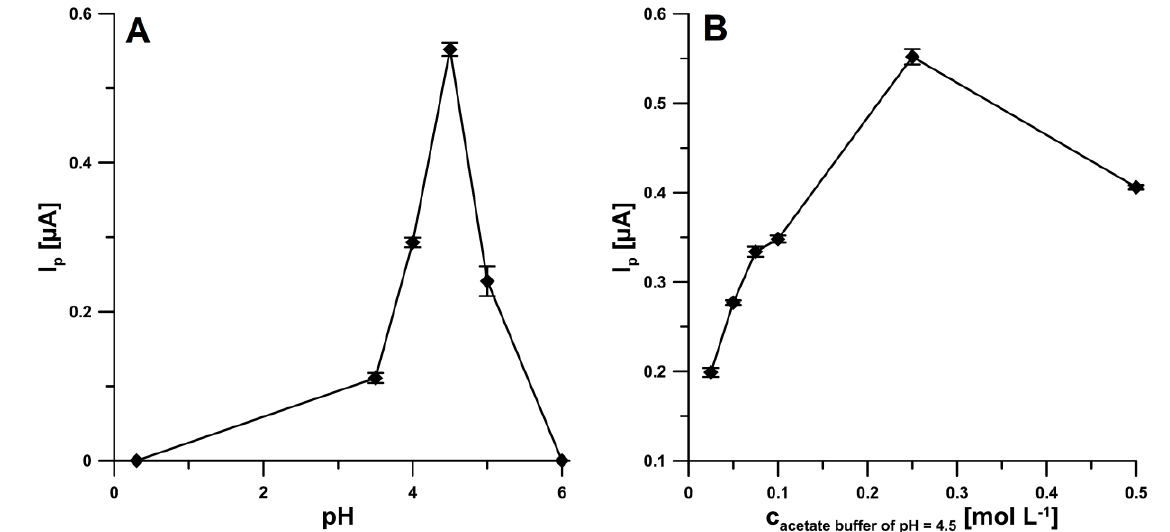
Figure 2. Effect of pH ( A ) and acetate buffer concentration ( B ) on the analytical signal of 20.0 µM IBP.